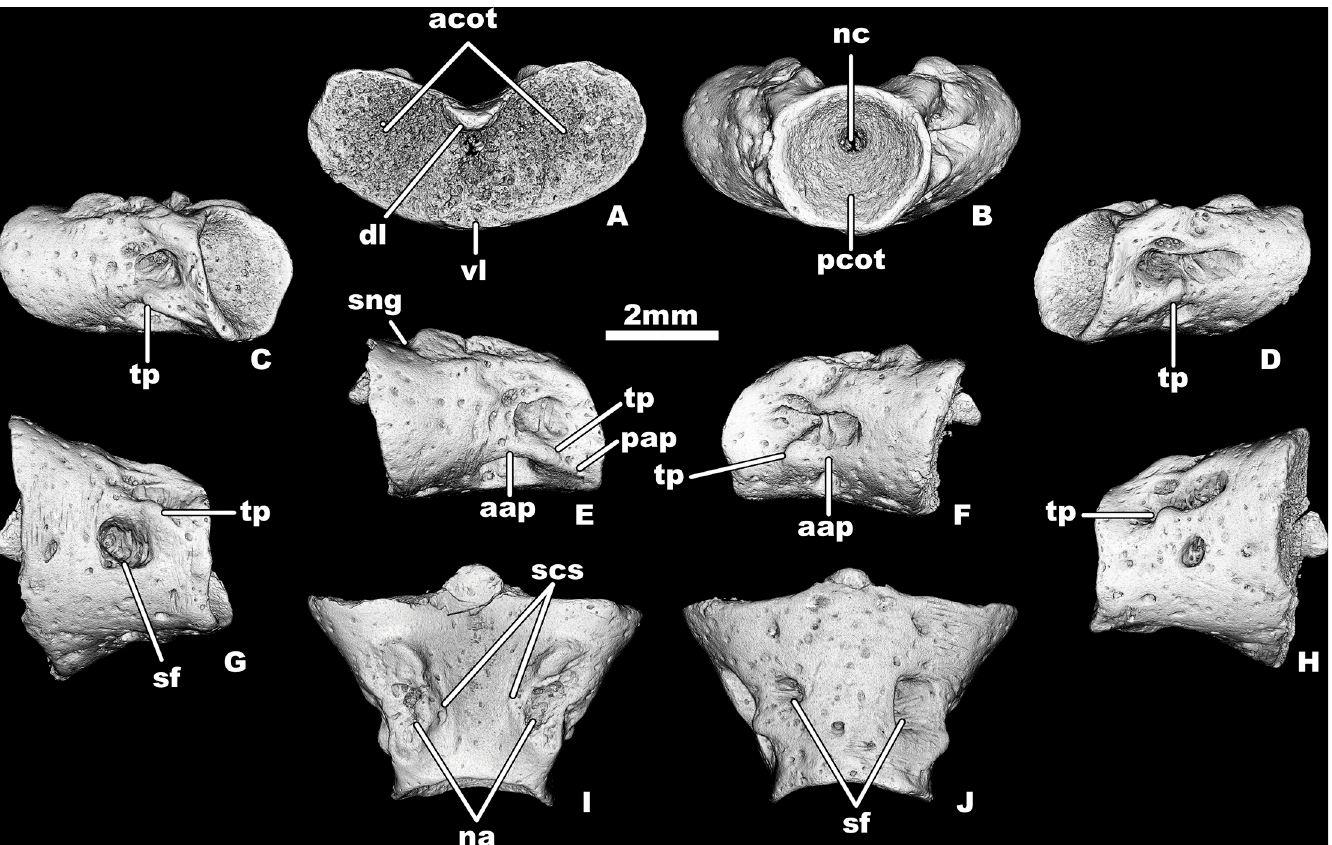
Fig 1. Egoria malashichevi gen. et sp. nov., digital restoration of atlantal centrum ZIN PH 40/144 (holotype), in anterior (A), posterior (B), posterior-left lateral (C), posterior-right lateral (D), left lateral (E), right lateral (F), ventral-left lateral (G),ventral-right lateral (H), dorsal (I) and ventral (J) views. Abbreviations: aap–anterior alar process, acot–anterior cotyle, dl–dorsal lip of intercotylar process, na–neural arch pedicel, nc–notochord canal, pap–posterior alar process, pcot–posterior cotyle, scs–spinal cord supports, sf–subcentral foramen, sng–spinal nerve groove, tp–transverse process, vl–ventral lip of intercotylar process. All images at same magnification.